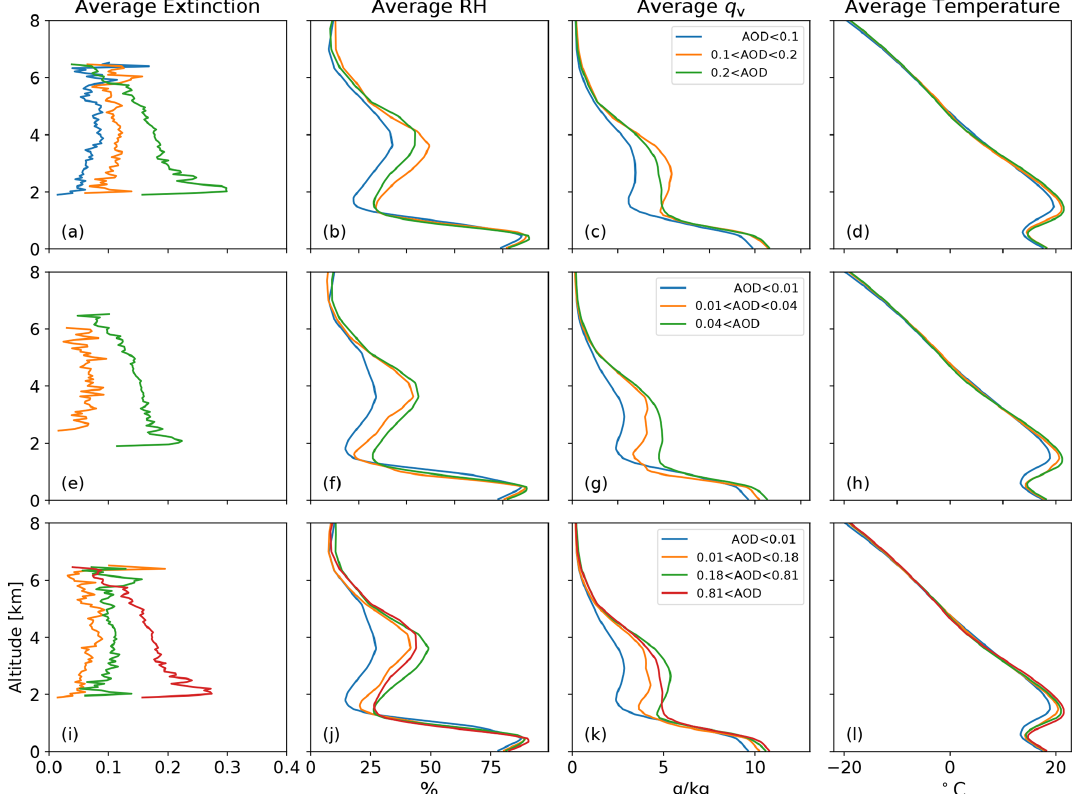
Figure A8. Mean profiles of aerosol extinction, relative humidity (RH), specific humidity ( q v ), and temperature for CALIPSO profiles containing aerosols above clouds during the month of September from 2007 to 2010. The data used for panels (a–d) , (e–h) , and (i–l) are exactly the same. The only difference is the selection of the interval limits and interval number for which the mean values are computed. The aerosol optical depth (AOD) values are obtained from CALIPSO Aerosol Profile Data product. RH, q v , and temperature are originally from MERRA-2 and added along the satellite track to the CALIPSO Aerosol Profile Data